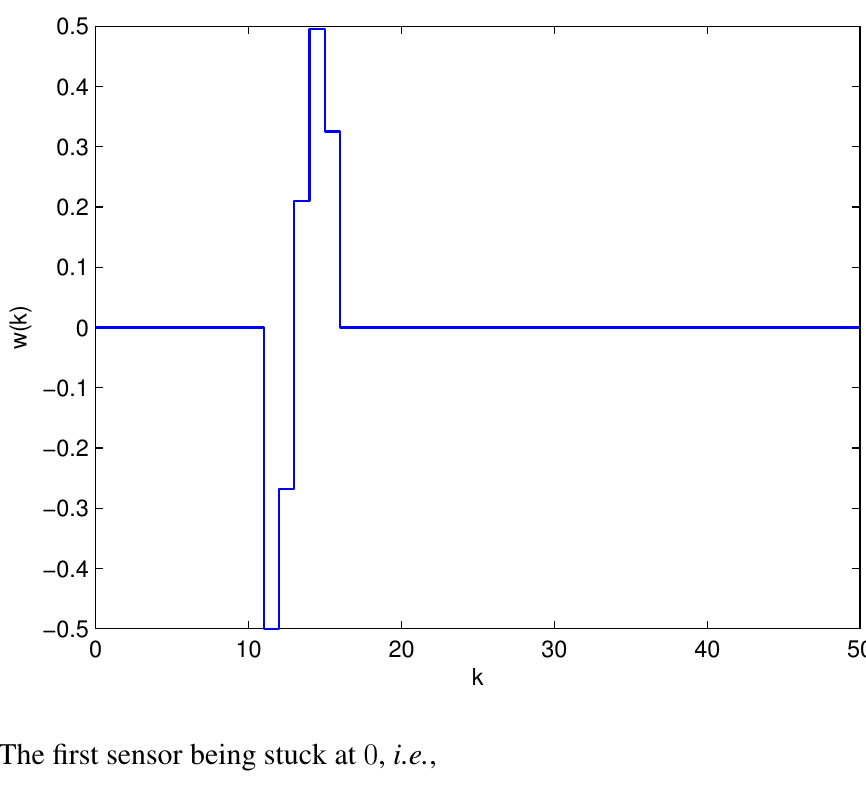
Figure 3. The disturbance input w ( k )